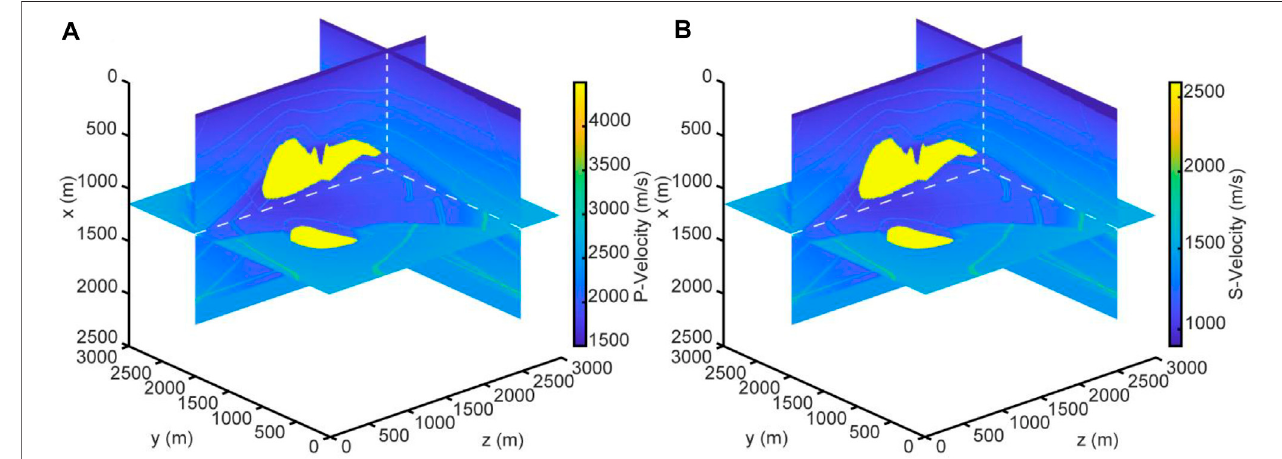
FIGURE 6 | Partial SEG/EAEG salt velocity models of (A) P-wave and (B) S-wave.